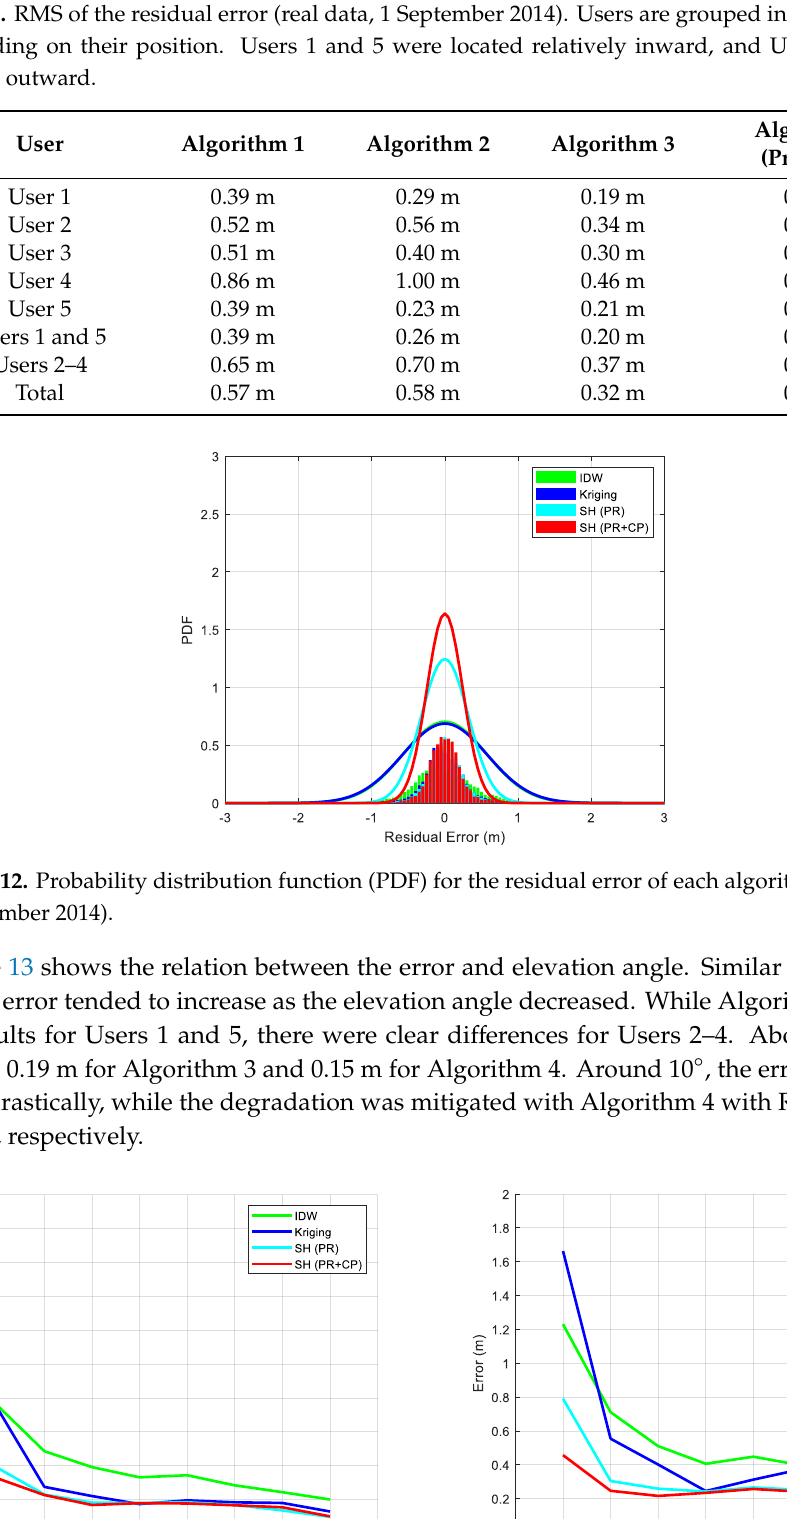
( b ) Figure 13. Residual error according to the elevation angle (real data, 1 September 2014): ( a ) Users 1 and 5; ( b ) Users 2 – 4. The second test was carried out under active conditions. The test results are represented in a manner similar to the previous results. Table 4 lists the RMS of the residual error in the range domain for the real data test. Figure 14 presents the error distribution of each algorithm.